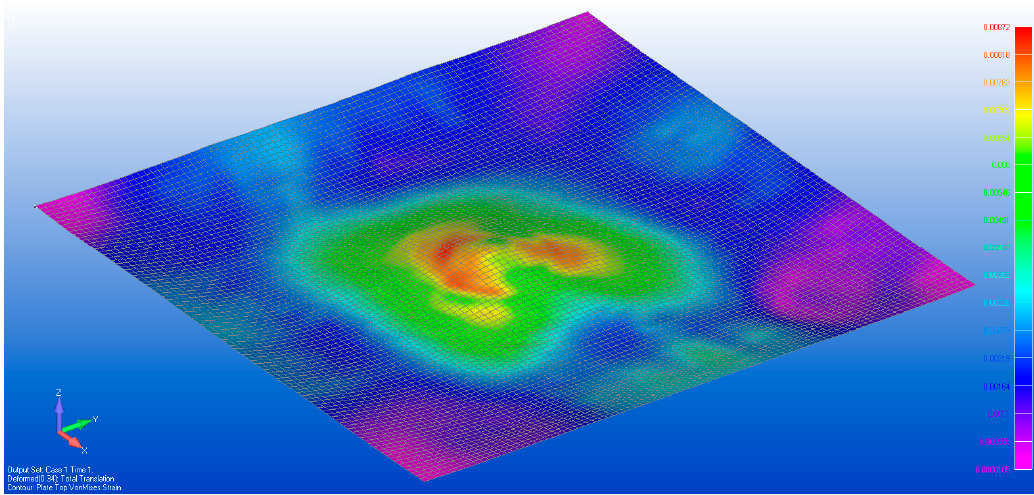
Figure 29. The von Mises strain caused by tripod support.